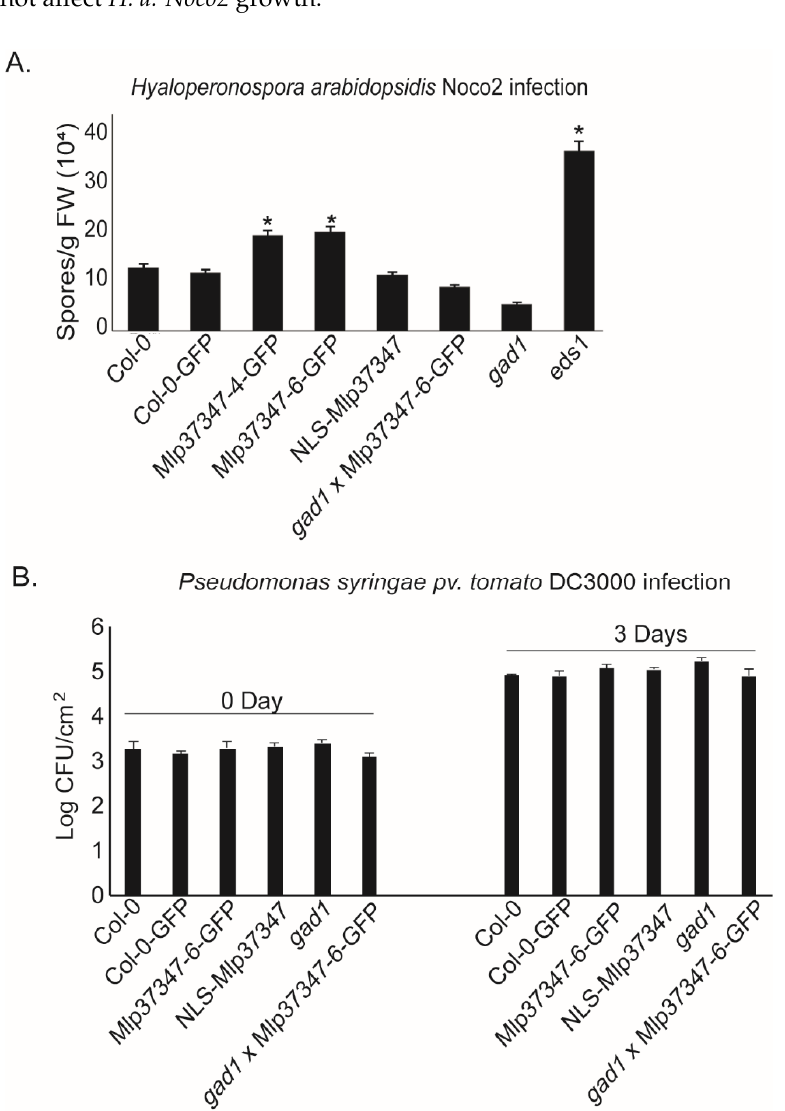
Figure 6. Mlp37347 increases the susceptibility of A. thaliana to H. arabidopsidis . ( A ) Growth of Hyaloperonospora arabidopsidis Noco2 inoculated at 20,000 conidiospores/mL. The number of spores/g fresh weight was quantified seven days after inoculation. Bars represent the mean of four replicates. Statistical significance with Col-0 was evaluated using Student’s t -test ( p < 0.05) and was denoted as an asterisk. ( B ) The number of colony forming units of Pst DC3000 was measured on day 0 and day 3 after infection of 4-week-old soil-grown plants by leaf infiltration. A bacterial suspension with OD600 = 0.001 was used as inoculum. Statistical significance was evaluated using Student’s t -test ( p <